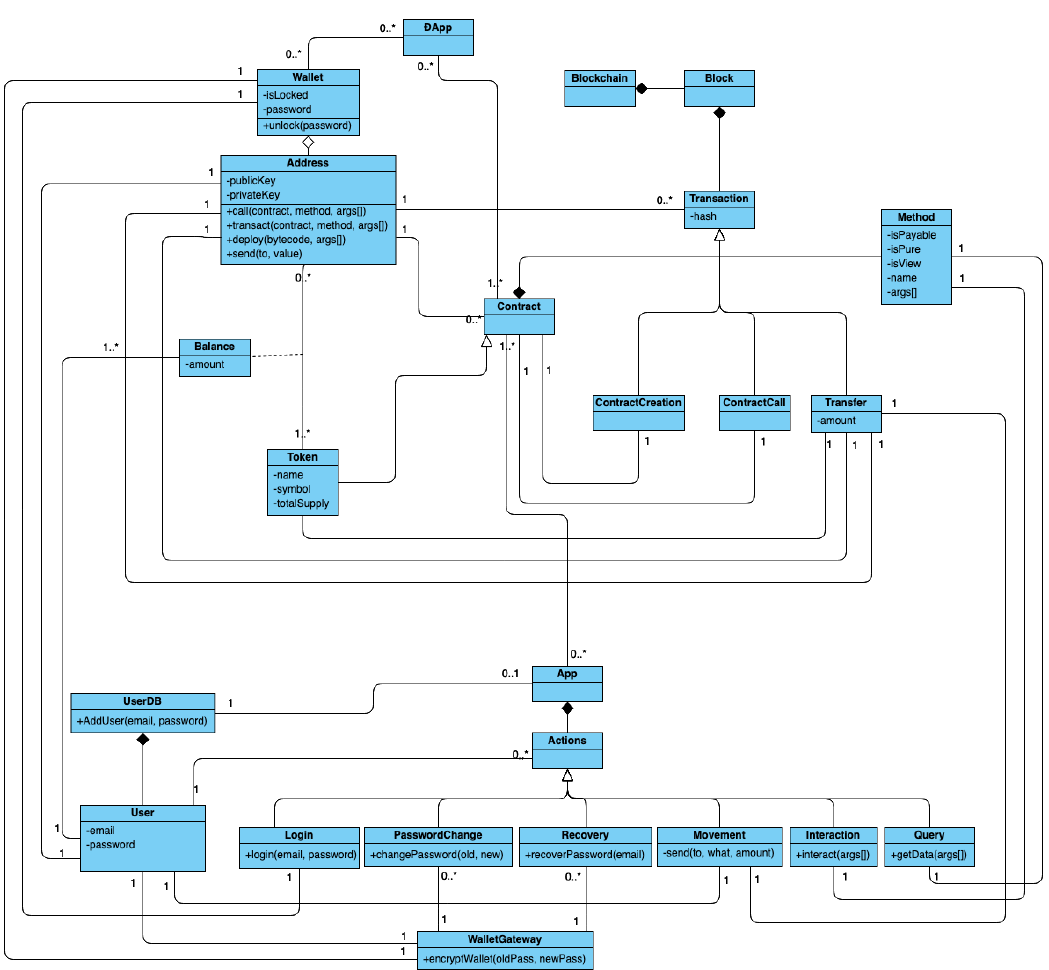
Figure 1. Relationship among blockchain decentralized applications (ÐApp’s) and application (App) elements.